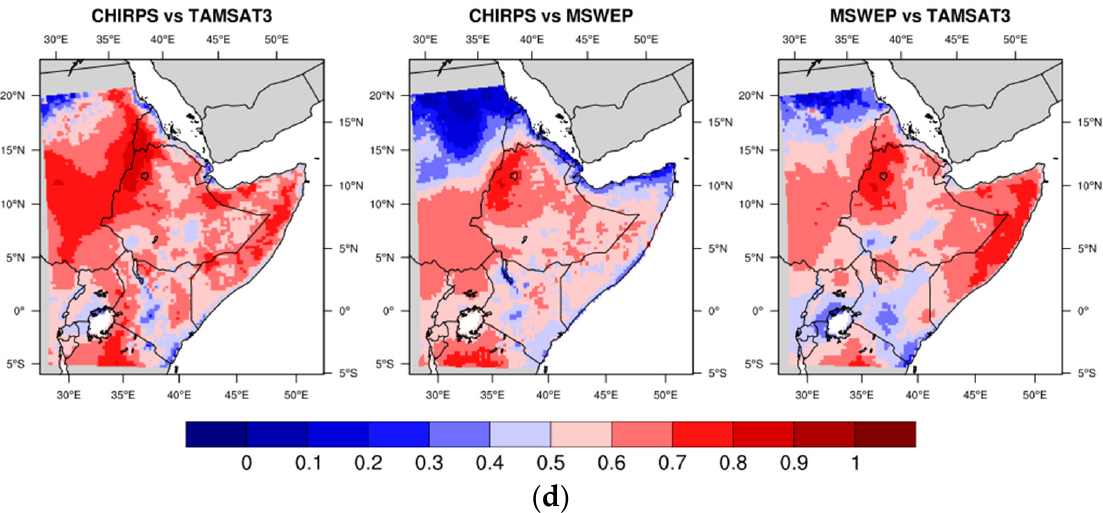
Figure 11. Maps of POD ( a ), FAR ( b ), BIAS ( c ), and HK ( d ) for EA. Table 3. POD, FAR, BIAS and HK spatially averaged over EA with the corresponding standard deviation values.